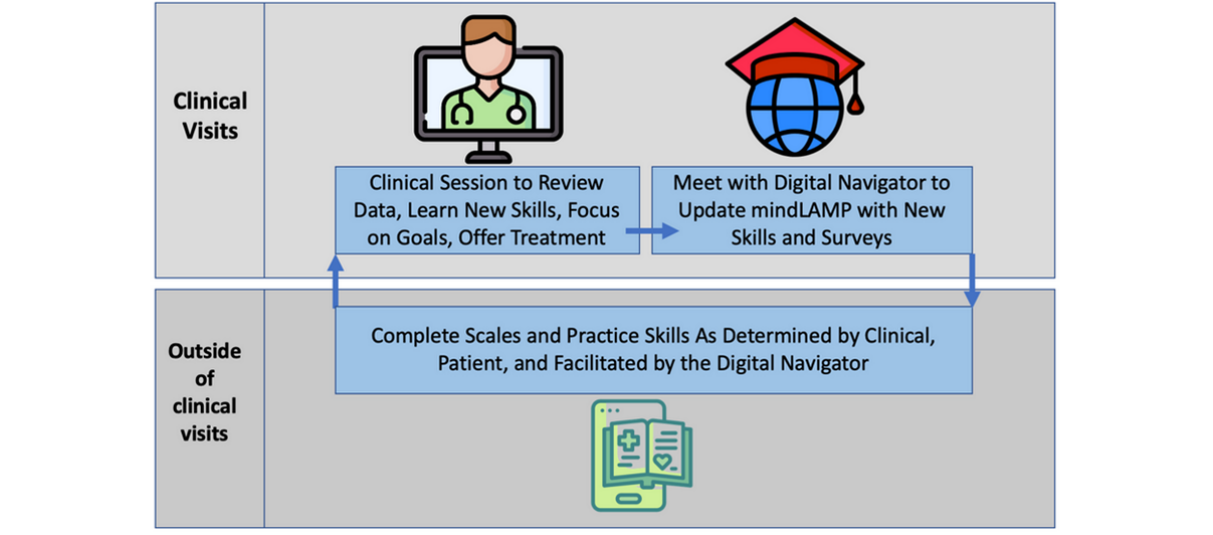
Figure 1. The Digital Clinic program structure including pre- and postclinical activities.